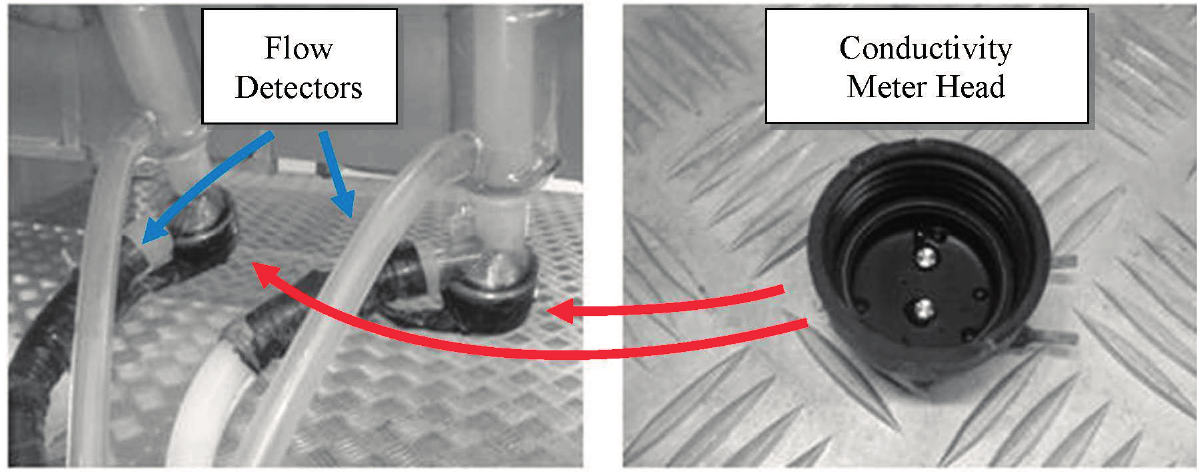
Figure 2. View of prepared sensor heads. In the left picture, the positions of the conductivity meter heads and of the flow detectors, included in each experimental milking cluster, are also